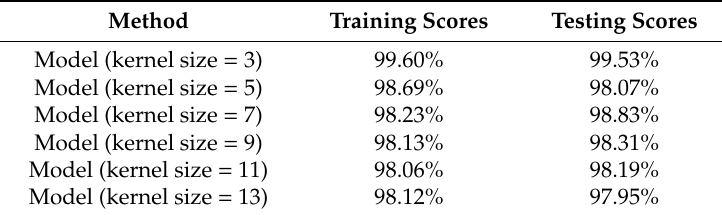
Table 5. Comparing the training and testing scores of models using various kernel